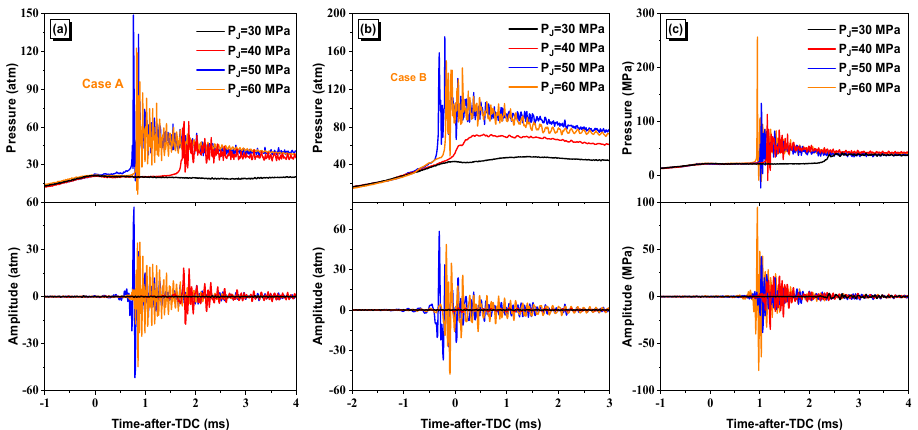
Figure 3. Pressure traces and amplitude of pressure oscillations at ( a ) P c = 20 atm, δ = 1.5 ms; ( b ) P c = 40 atm, δ = 1.5 ms; and ( c ) P c = 20 atm, δ = 2.0